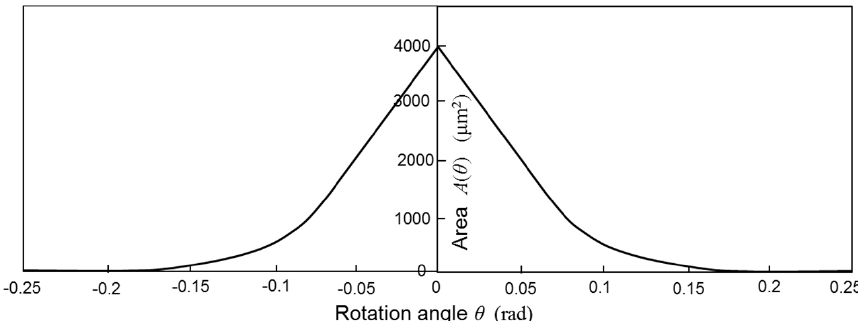
Figure 3. Superposed area of comb fingers as a function of rotation angle.